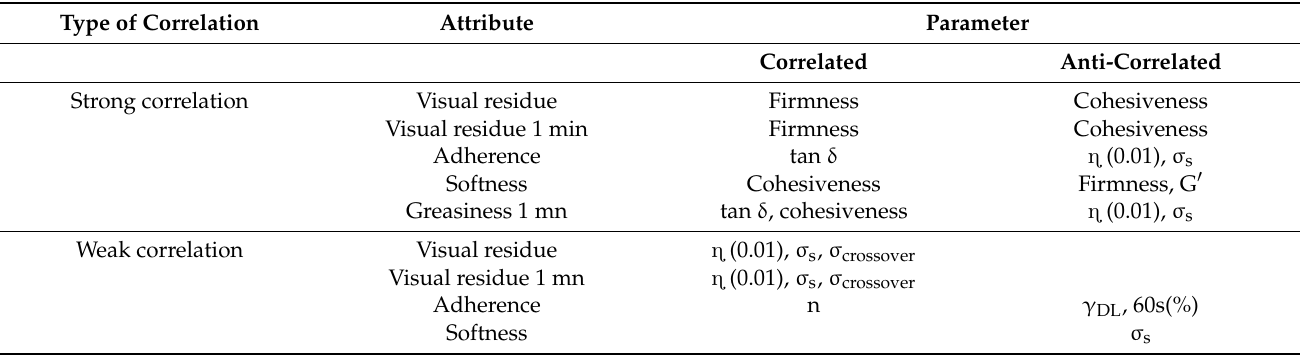
Table 15. Summary of strong and weak correlations between selected attributed and instrumental